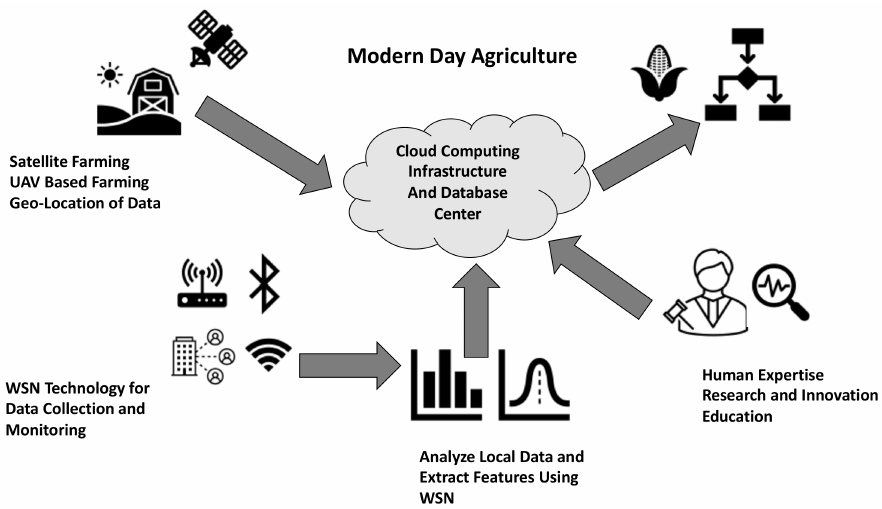
Figure 3. Modern day